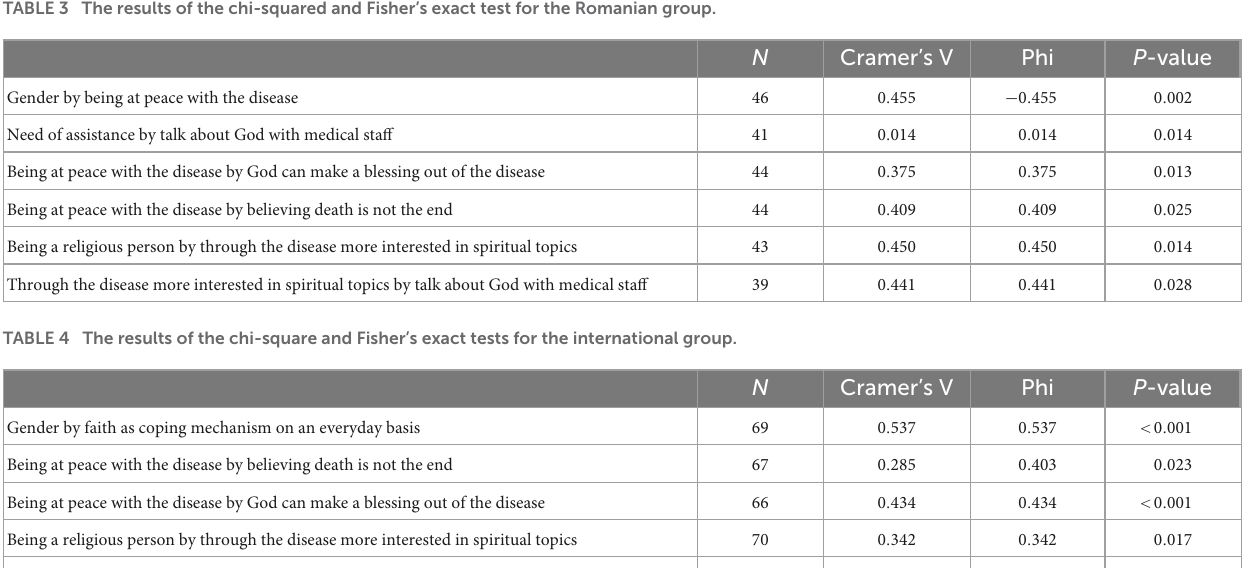
TABLE 3 The results of the chi-squared and Fisher’s exact test for the Romanian group.